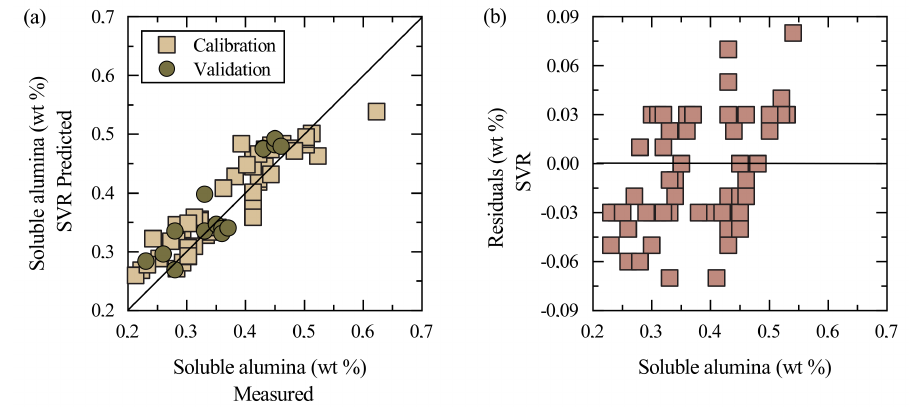
Figure 2. ( a ) Measured vs Predicted plot of the updated SVR model in the calibration and validation samples, and ( b ) their respective